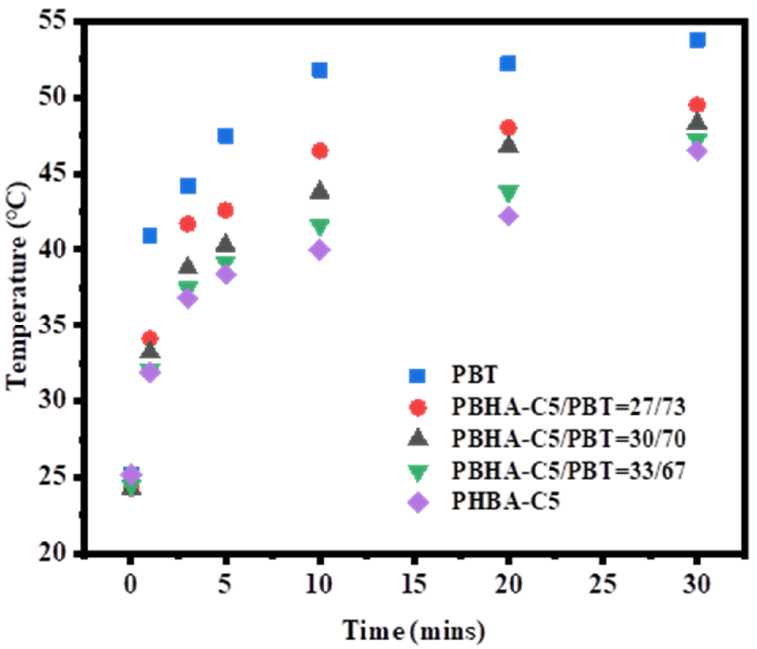
Figure 13. Plots of the surface temperature change in samples as a function of time.